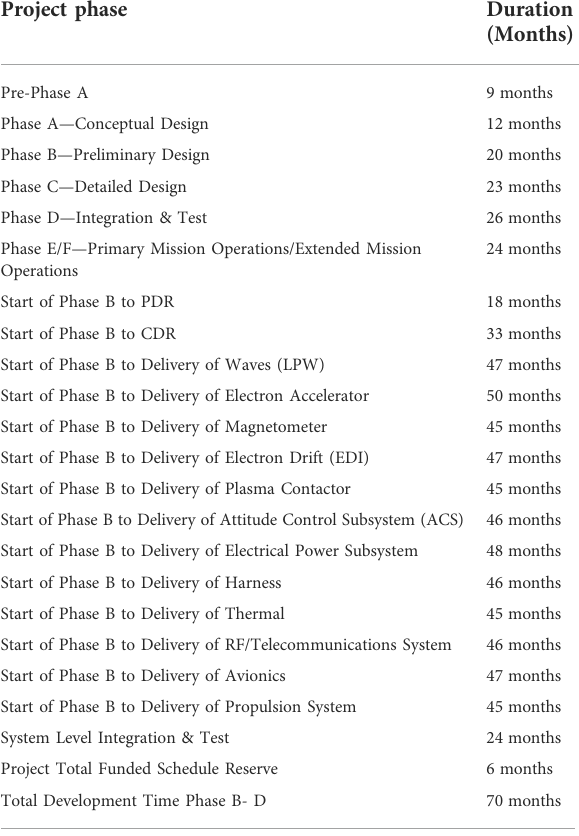
TABLE 5 Key phase duration table for the MIO mission